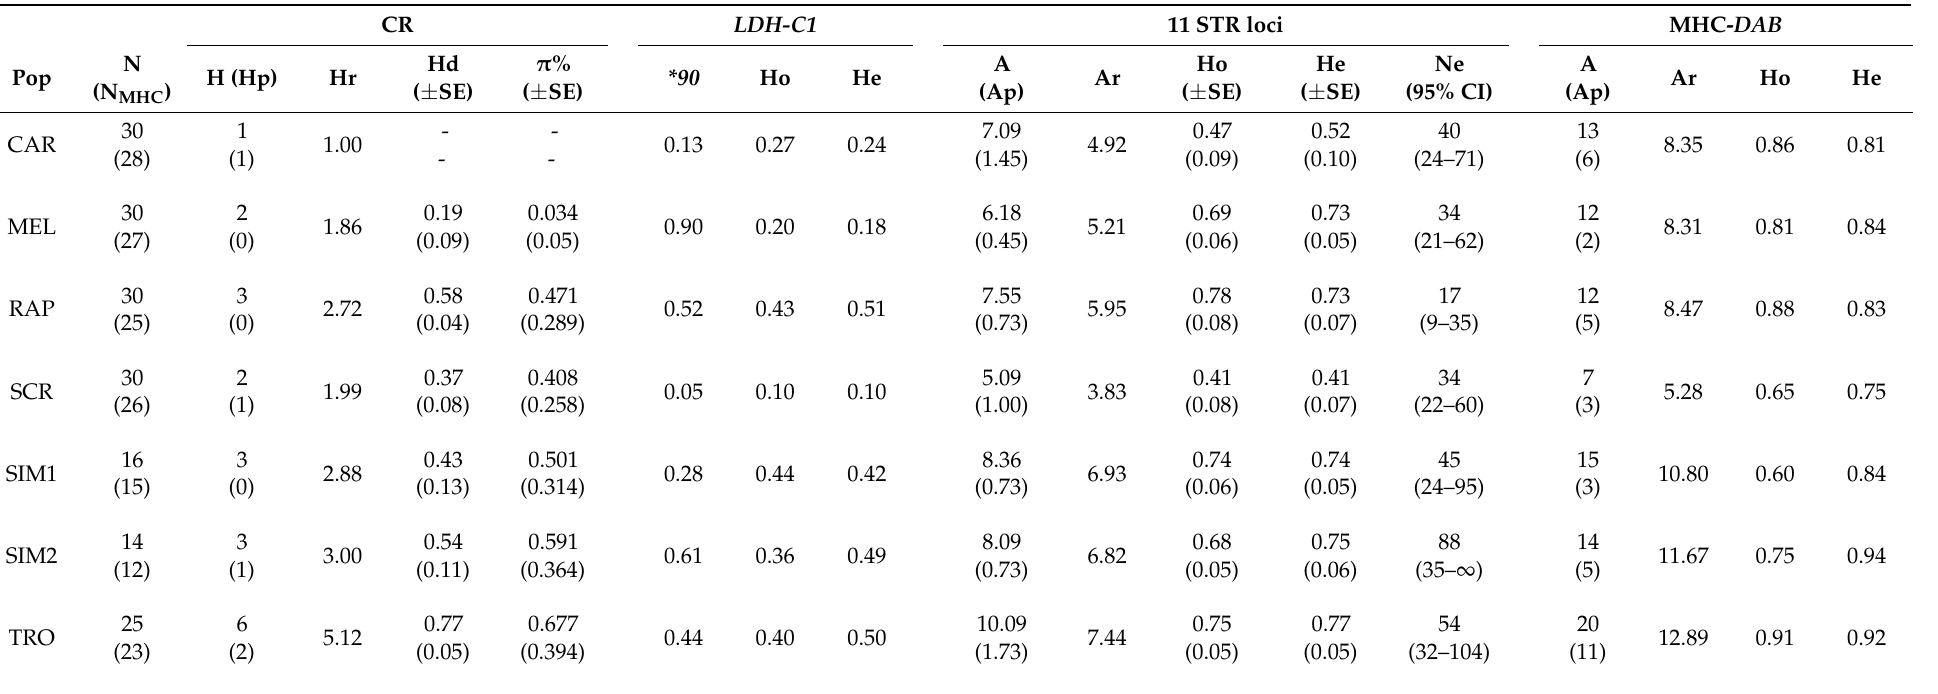
Table 2. Genetic variability parameters for each marker across seven Mediterranean brown trout sampling sites (Pop). N, number of individuals collected and analyzed for CR, LDH-C1, and STRs; N MHC , number of individuals analyzed at the MHC- DAB locus; H, number of haplotypes and of private haplotypes (Hp); Hr, haplotype richness; Hd, haplotype diversity; π , nucleotide diversity; * 90 , frequency of the Atlantic LDH-C1*90 allele; A, number of alleles and of private alleles (Ap); Ar, allelic richness; Ne, effective population